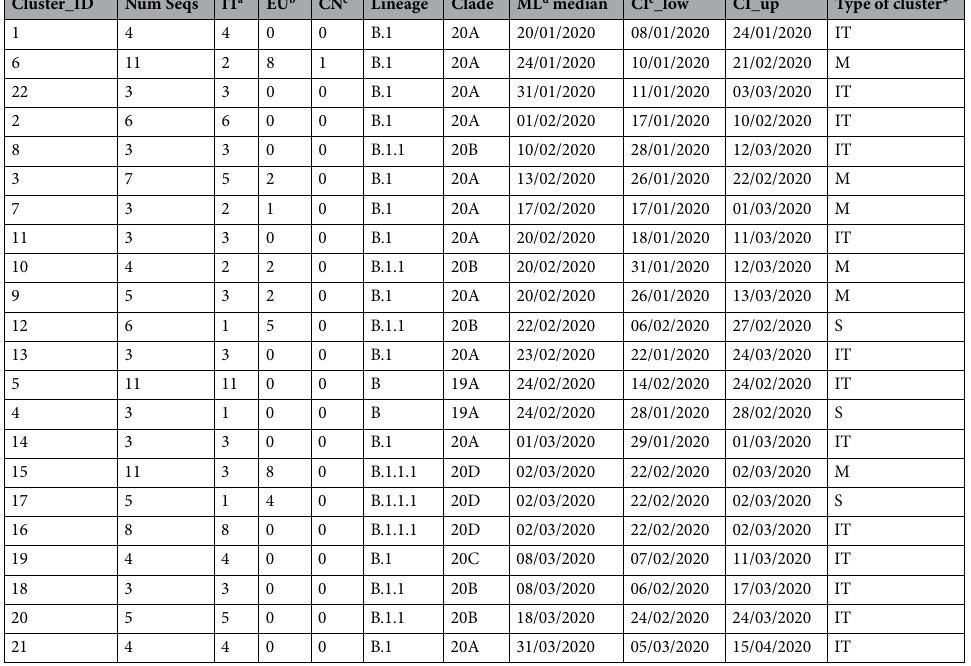
Table 4. Main characteristics of the identified clusters. a Italian strains. b European strains, with the exception of Italy. c Chinese strains. d Maximum likelihood. e Confidence Interval. *Type of cluster: M, mixed; IT, Italian; S, single Italian